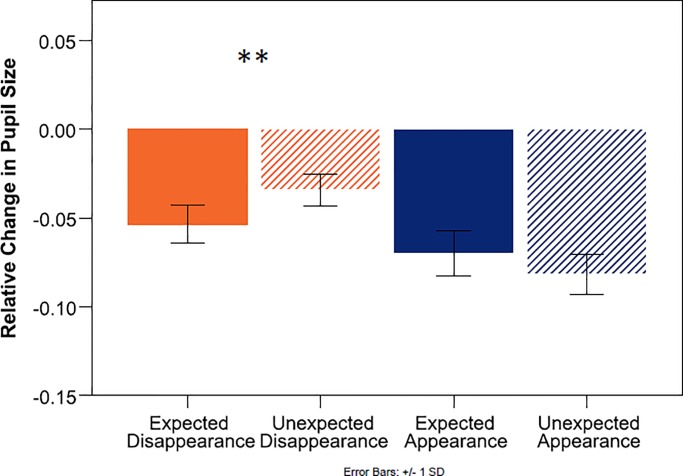
Mean change in pupil size relative to baseline in 18-months-olds.Note that a smaller negative deviation from zero denotes a larger pupil.